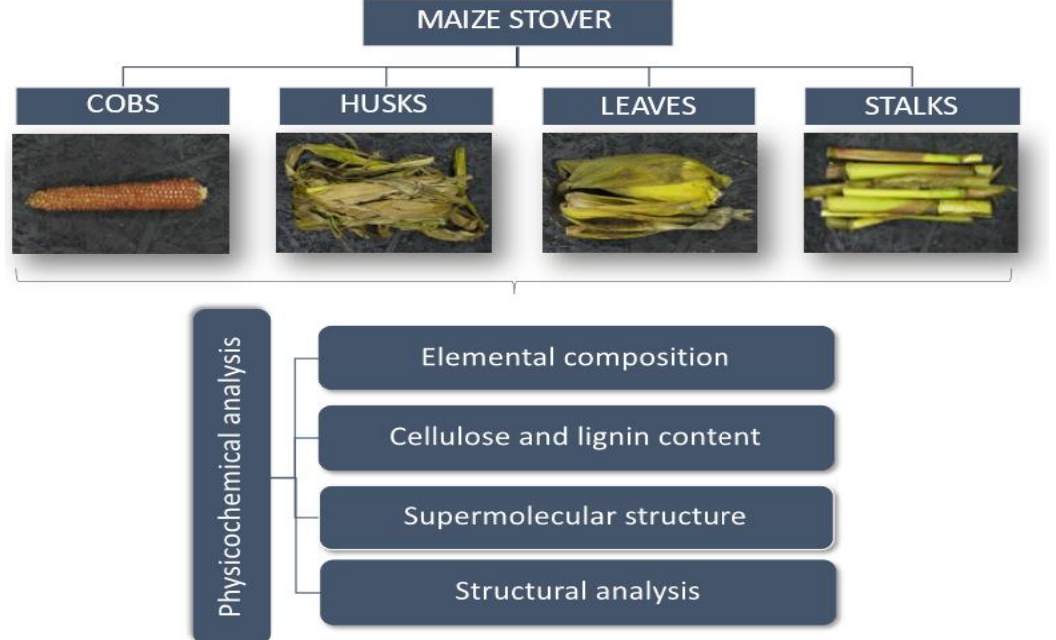
Figure 1. The scheme for characterization of maize stover fractions.